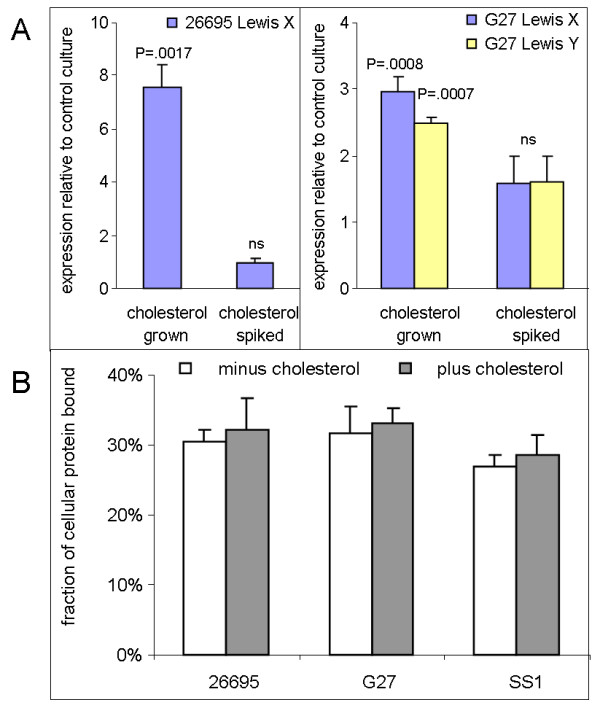
ELISA control experiments. A. Spiking with cholesterol at the end of the growth period does not alter Lewis antigen expression. Cultures of H. pylori were grown overnight in defined medium without (control) or with 50 μg/ml cholesterol (cholesterol grown). A third flask (cholesterol spiked) was grown in the absence of cholesterol, chilled on ice, and an equivalent amount of cholesterol was added before the cells were harvested. Lewis antigens were quantitated in duplicate by whole-cell ELISA, loading 300 ng cellular protein per well. Ratios for plus:minus cholesterol were calculated from average net absorbance readings in each assay, and the plot displays mean ratios ± sem for three to five independent ELISA runs. P values were calculated in two-tailed Student t-tests for the null hypothesis that the ratio equals 1. For comparisons labeled ns, P > .05. B. Equivalent binding of cells to ELISA plates. Samples of H. pylori that were grown in parallel cultures in the absence (white bars) or presence of 50 μg/ml cholesterol (grey bars) were applied to multiwell plates in the same manner as for Lewis antigen ELISA assays, adding 500 ng of cellular protein per well. Following overnight attachment, wells were washed twice with Dulbecco's phosphate-buffered saline, then protein in adherent cells was quantitated using the BCA reagent. Mean values ± sd of quadruplicate wells are shown.